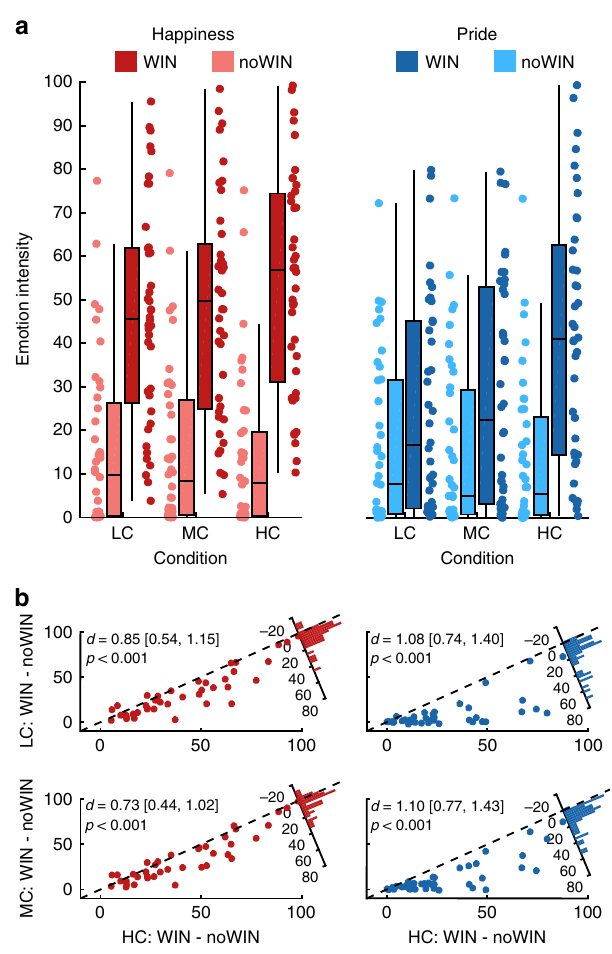
Fig. 2 Task effects on emotion ratings. a Emotion ratings from study 1, separate for pride and happiness, high, medium, and low control as well as outcome valence. b Scatterplots depict reactivity to WIN vs noWIN outcomes for happiness (left) and pride (right) in dependence of perceived control ( x -axis: HC; y -axis (top): LC; y -axis (bottom): MC). Top and bottom rows depict relationships between emotion reactivity in LC and HC, as well as MC and HC, respectively. Histograms in top right corners visualize the differences in emotion reactivity between HC and LC (top row), or HC and MC (bottom row). HC high control, MC medium control, LC low control. d = Cohen ’ s d . Values in brackets represent 90% con fi dence intervals for d . The center line of boxplots depicts the median, the upper and lower box borders are the 25th and 75th percentile, and the length of the whiskers is 1.5 times the interquartile range. Source data are provided as a Source Data fi